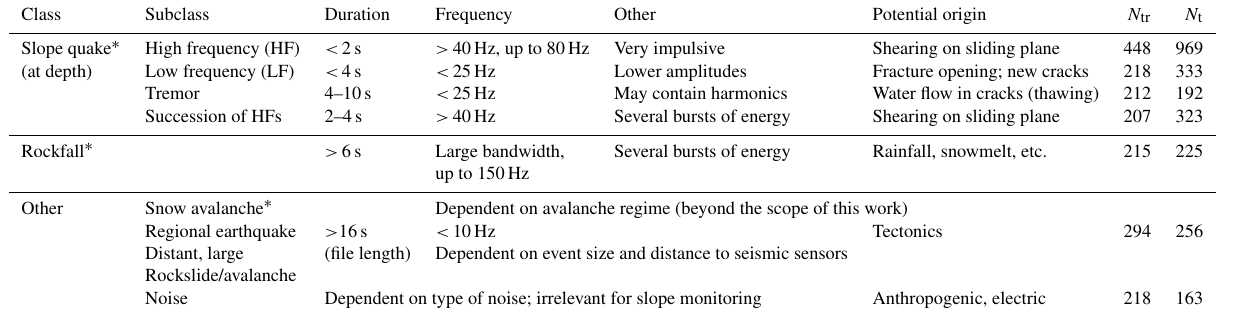
Table 1. Summary of the seismic event classes identified at Åknes. Asterisks ( ∗ ) indicate events that occur directly on the slope and are therefore relevant and meaningful for the monitoring. Hypotheses on the physical processes causing the events are provided, inferred both from the literature and the observations at Åknes developed in Sect. 5. N tr and N t are the number of events constituting the training and test sets, respectively. Probability density functions of the main signal characteristics are shown in Fig. B18 in the